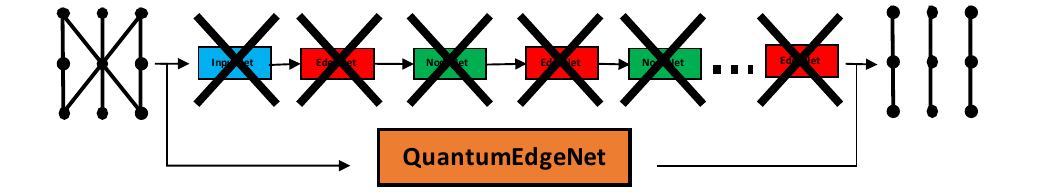
Figure 4. The HepTrkX GNN structure and the QuantumEdgeNet model used in this work.